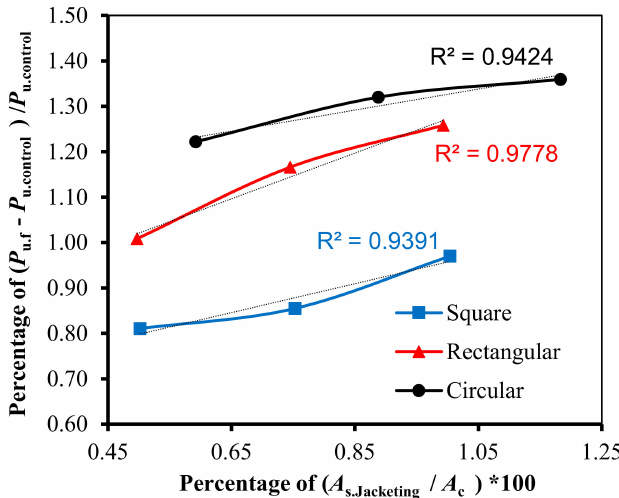
Figure 9. The relationship between the percentage of increase in column capacity and the percentage of longitudinal reinforcement in RC jacketing for di ff erent column cross-section shapes.